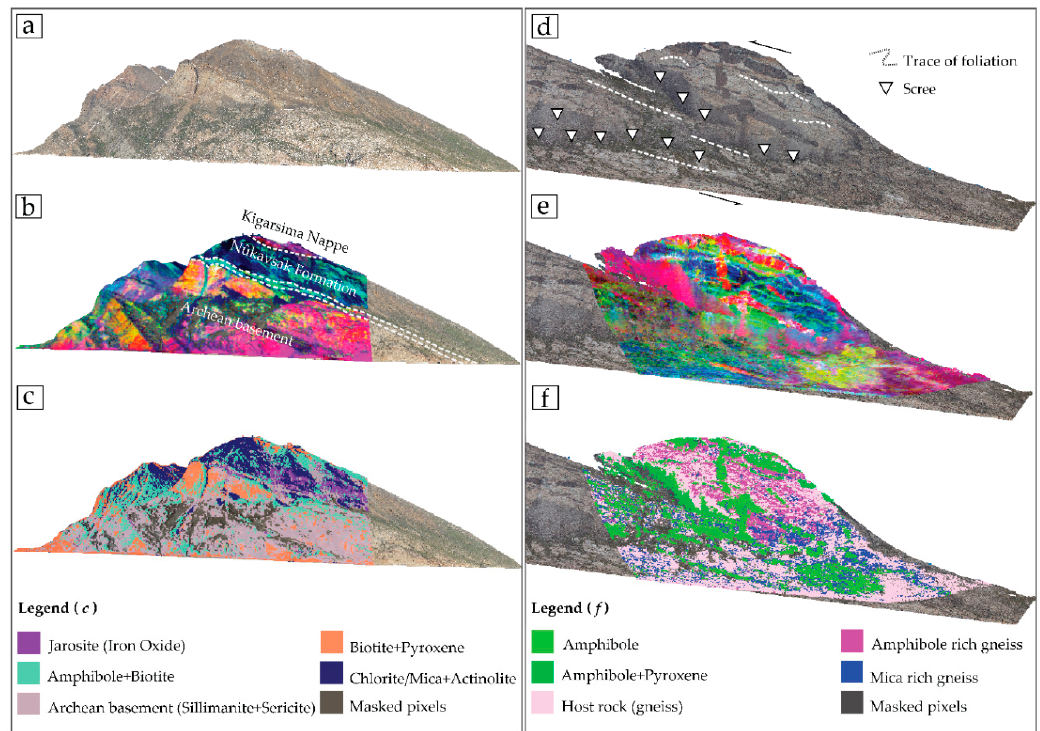
Figure 10. 2D RGB pseudo-orthophotos with the resulting classification images from the: ( a – c ) Karrat; and ( d – f ) Søndre Strømfjord regions draped on top. Pseudo-orthophoto textured with MNF image, where bands 2, 5, and 7 are visualized in RGB ( b , e ); and pseudo-orthophoto textured with SAM classification results ( c , f ). See Section 3.2.1 for a detailed description of matching hyperspectral products to the pseudo-orthophoto.